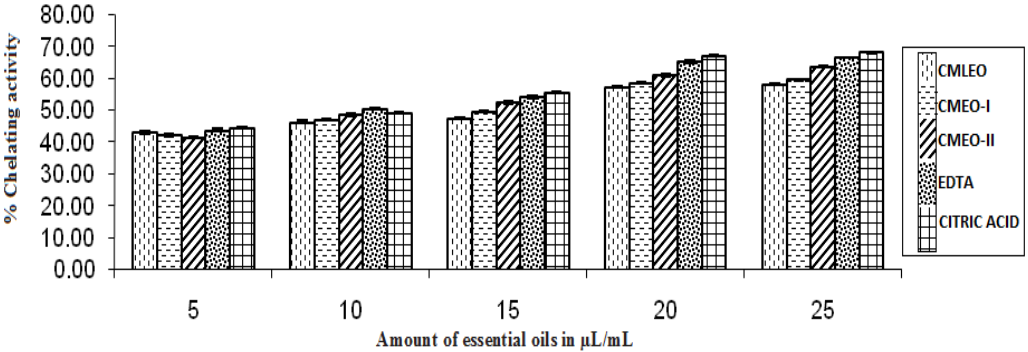
Figure 2. Chelating activity.